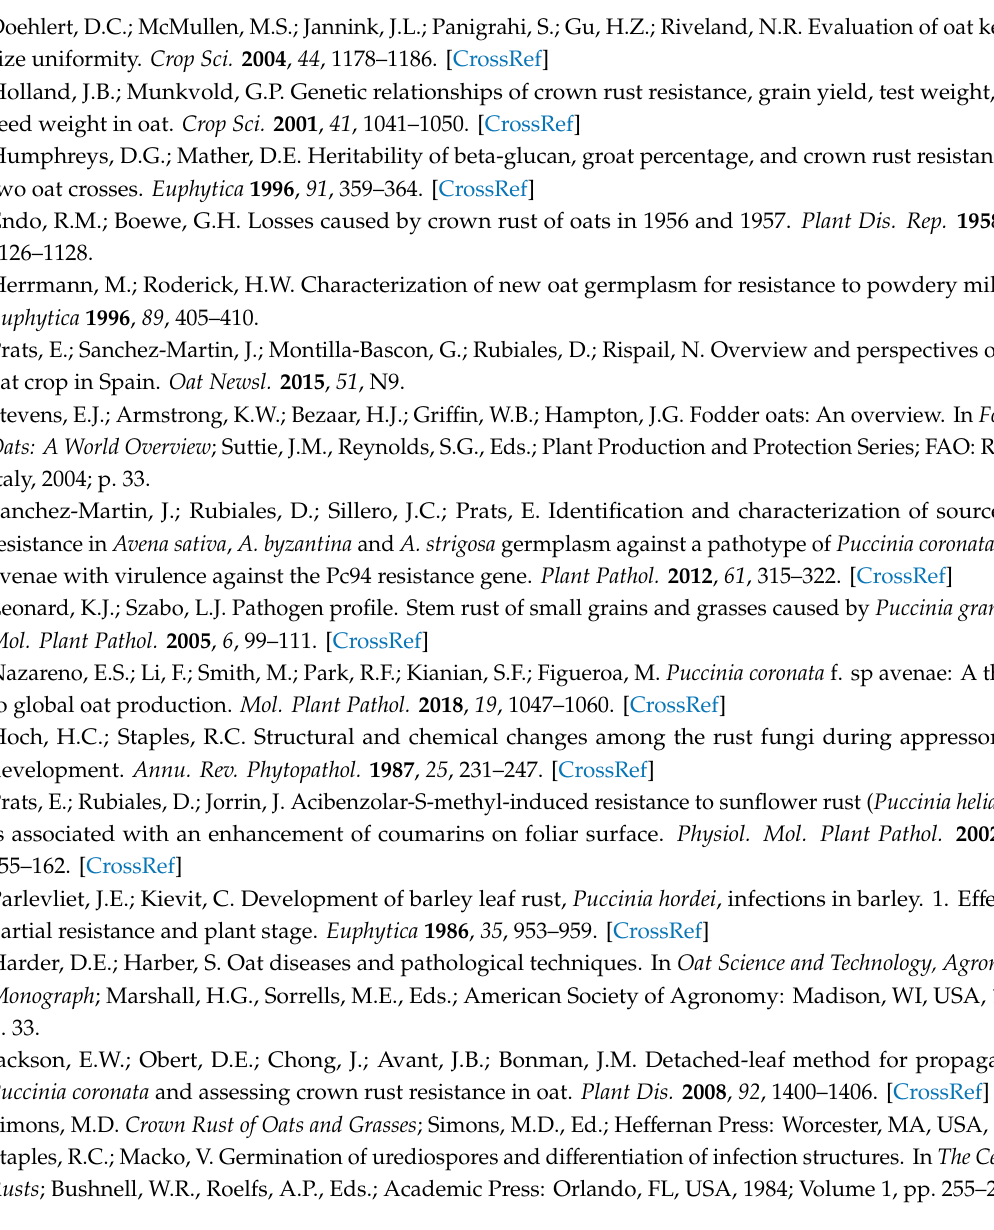
Figure S1. Template for calibration step; Script S2. RUST script for evaluation of rust diseases; Video S3. VideorepresentativeofMode1, Training, calibrationandsavingresultsincsv.format; VideoS4. Videorepresentative of Mode 2, selection of area manually and automatically, exporting data to excel file; Video S5. Video representative of Mode 3, and